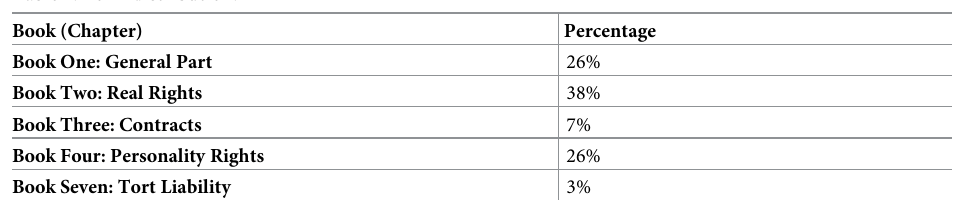
Table 2. Term distribution.